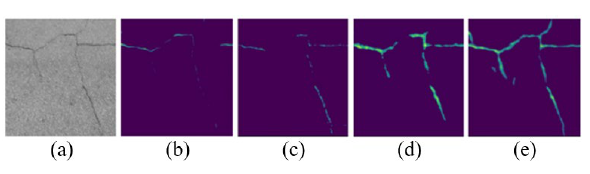
Figure 5. The results of different models for thin cracks: (a) original image, (b) Baseline U-Net, (c) VGG16 + BCE Loss, (d) VGG16 + Focal Loss, and (e) VGG16 + Focal Loss